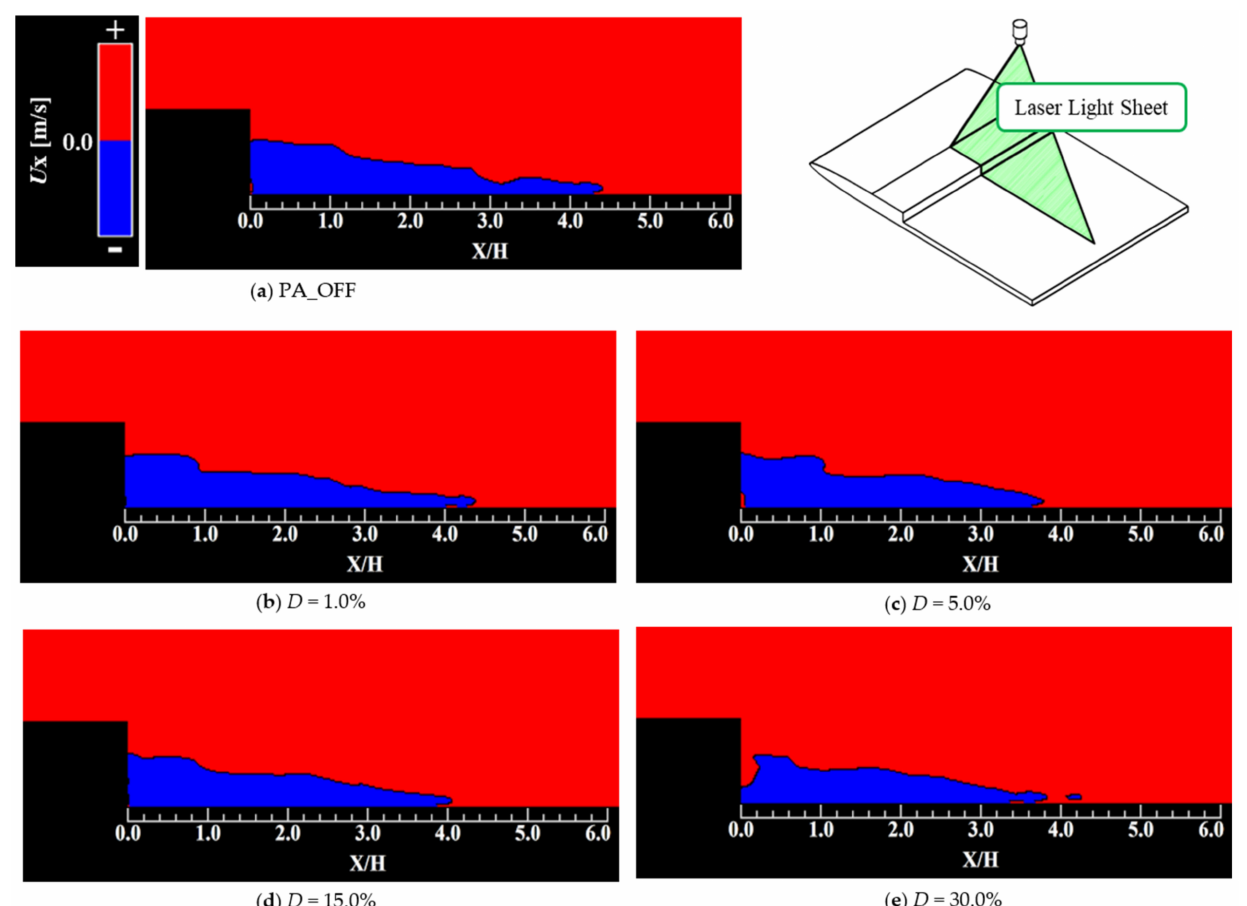
Figure 23. Iso- U x map (PIV results using dry snowflakes as tracers). Velocity Gradient